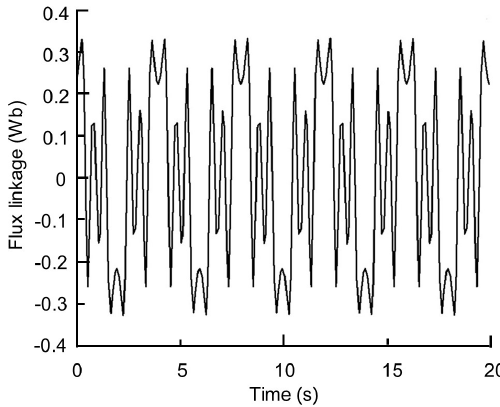
Figure 20. Variation curve of coil